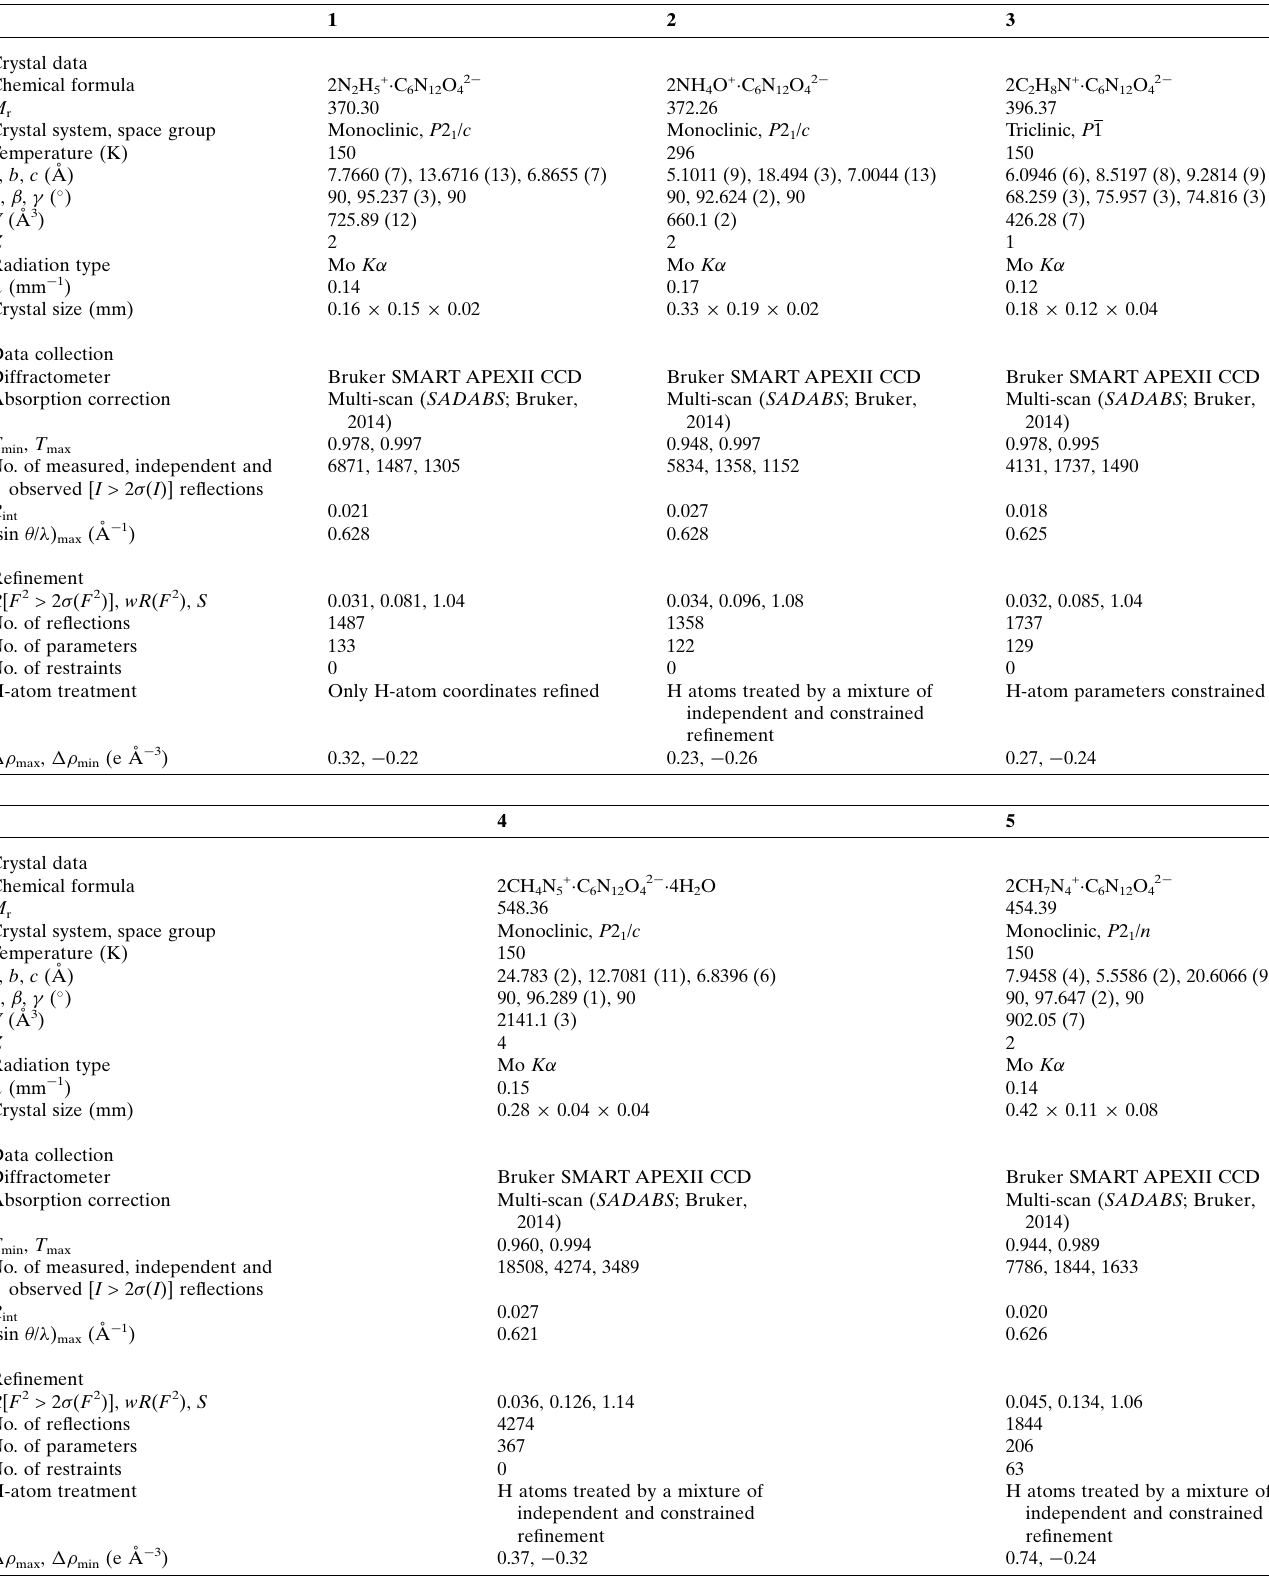
Table 7 Experimental